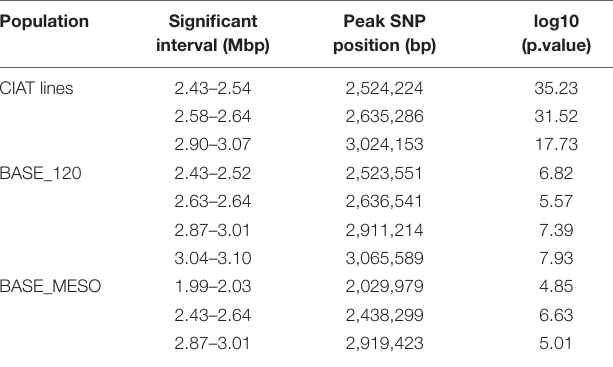
TABLE 3 | Summary of the GWAS results for reaction to BGYMV in three populations highlighting the bgm-1 region on chromosome Pv03.